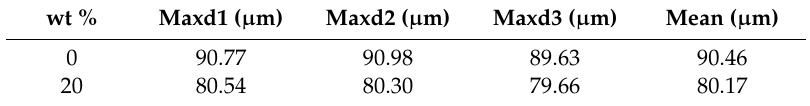
Table 6. Maximal displacement of workpiece thermal deformation with di ff erent carbon